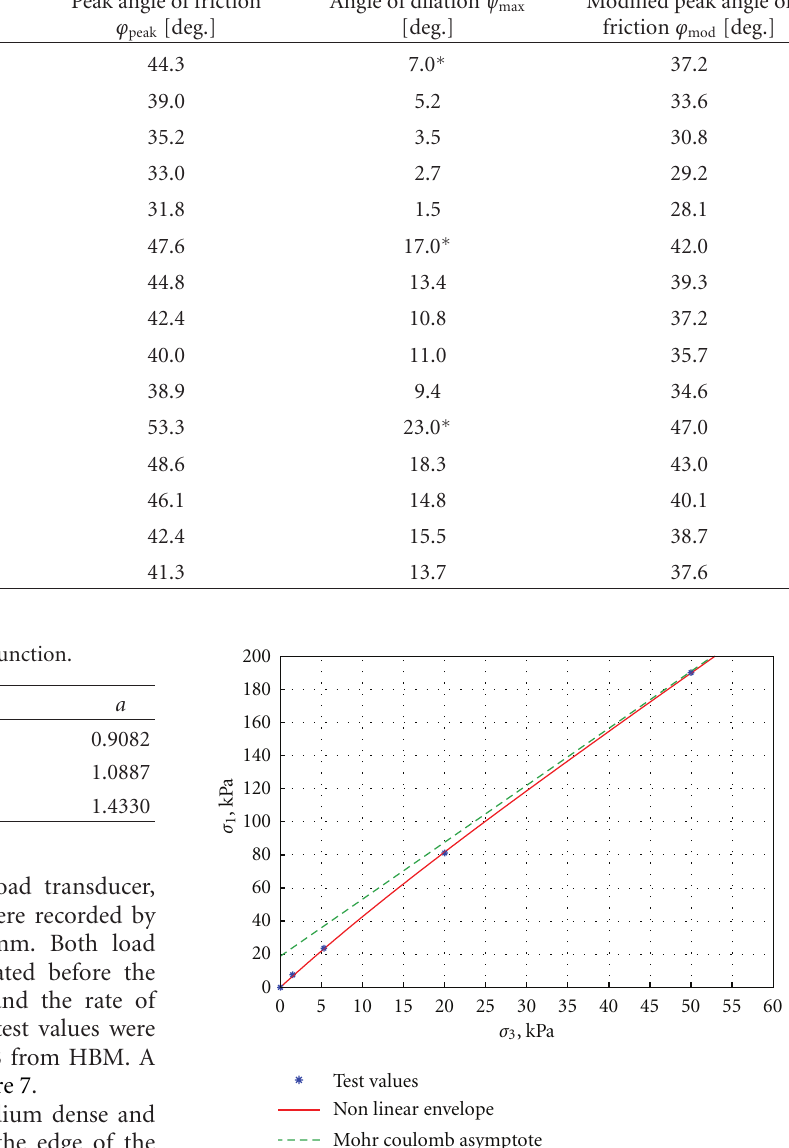
Figure 6: Failure envelopes and test results, D r = 0 .